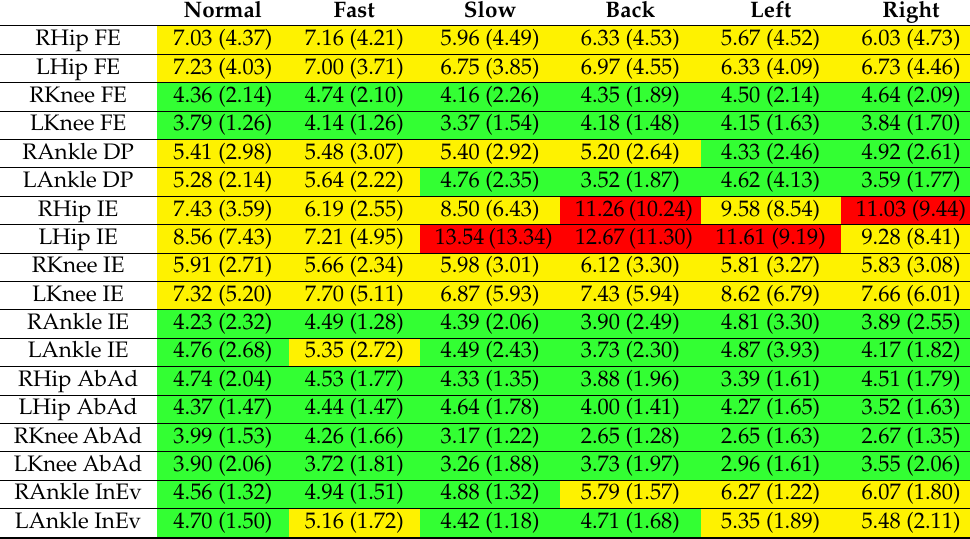
Table 3. Comparisons of joint angles with Inverse Kinematics Method. Mean (Standard Deviation) of RMS difference (IMU-IK) in estimates for each joint angle. All angles in degrees. Green, yellow, and red highlights indicate mean values <5 deg, <10 deg, and ≥ 10 deg, respectively. Results segmented by type of walking gait; namely normal forward (Normal), fast forward (Fast), slow forward (Slow), backward (Back), lateral left (Left), and lateral right (Right). Joint angles are flexion/extension (FE), internal/external rotation (IE), abduction/adduction (AbAd), dorsiflexion/plantarflexion (DP), and inversion/eversion (InEv). R and L prepended to joint names indicate right and left side, respectively.